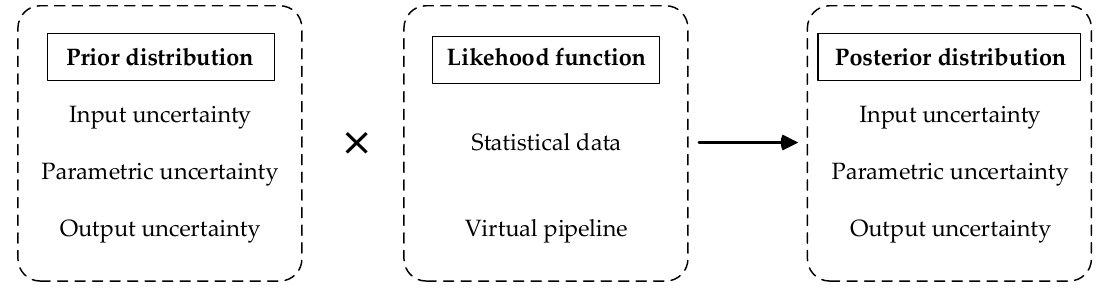
Figure 2. The principle of Bayesian fusion.